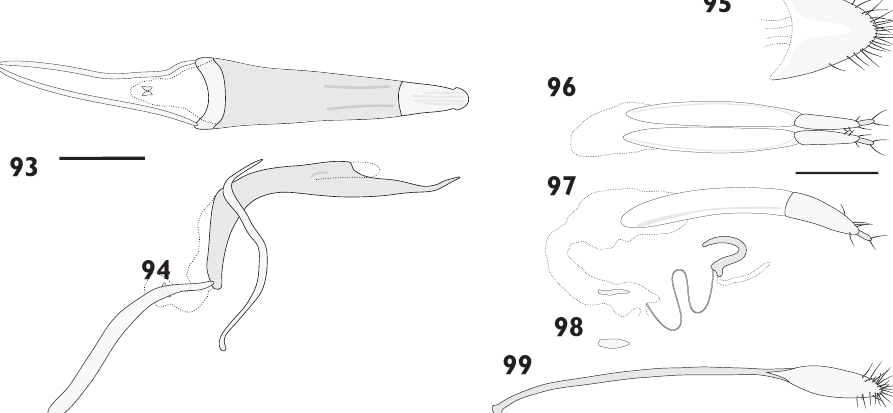
Figures 93–99. Genitalia of Austromonticola rotundus . 93 penis, dorsal view 94 aedeagus, lateral view 95 female tergite 8, dorsal view 96 ovipositor, dorsal view 97 ovipositor and spermatheca, lateral view 98 bursal sclerite, ventral view 99 female sternite 8, ventral view. Scale bars = 0.5 mm; 93–94 at same scale; 95–99 at same